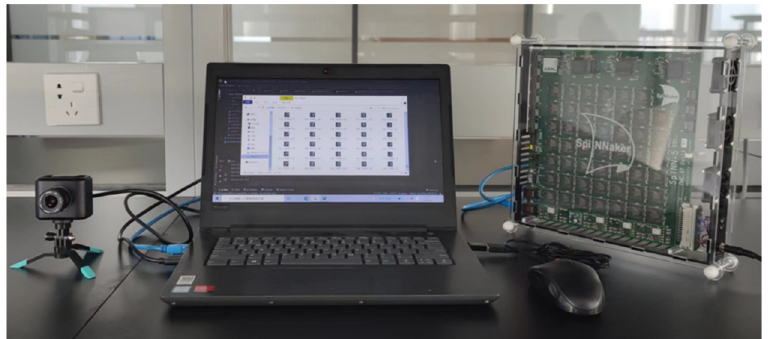
Figure 5. Photograph of the designed neuromorphic high-speed object recognition system based on DVS and SpiNNaker. In the system, DVS and SpiNNaker are both configured, controlled and monitored by a laptop. Table 1. Parameter values and model types used in the experiment.